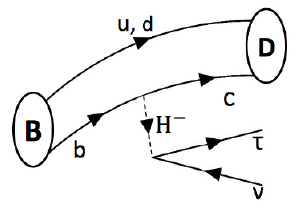
Figure 3 . Diagram that contributes to the B ! D(cid:28)(cid:23) .